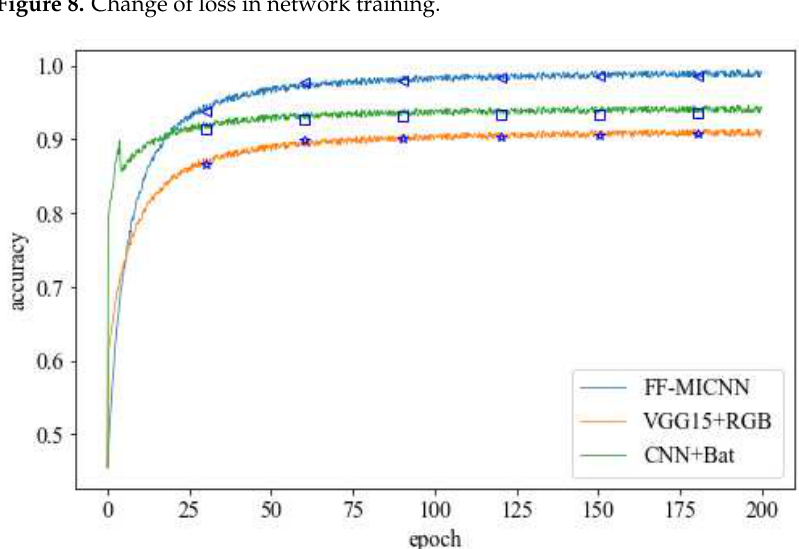
Figure 8. Change of loss in network training.